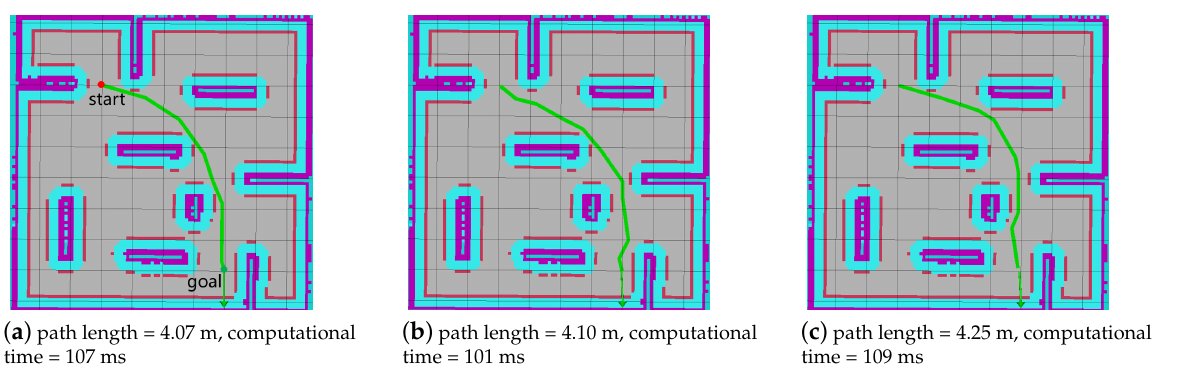
Figure 9. Solutions of RRT* in a scenario with multiple obstacles, 3000 iterations.